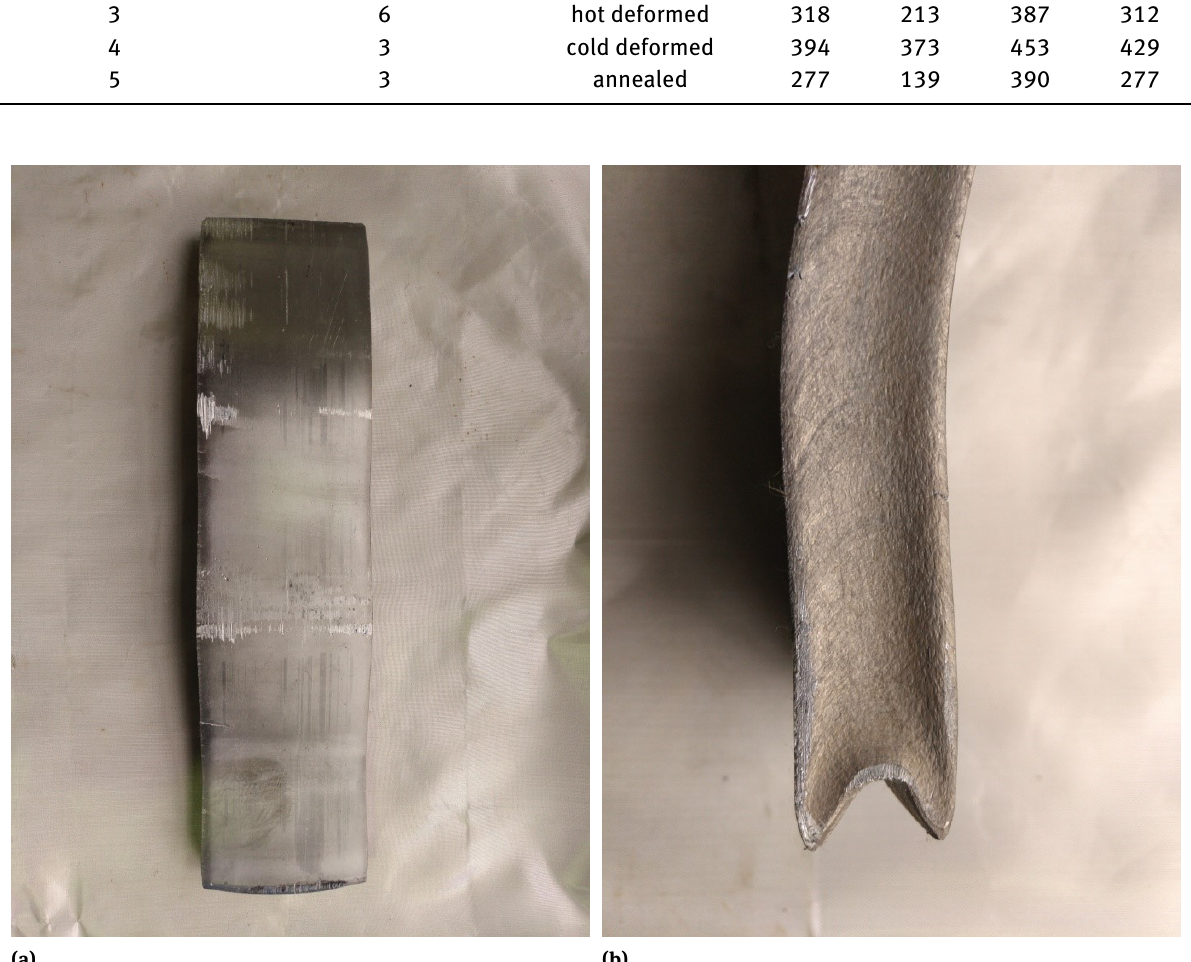
Figure 4: View of the first billet after rolling: a - from above; b - on the side